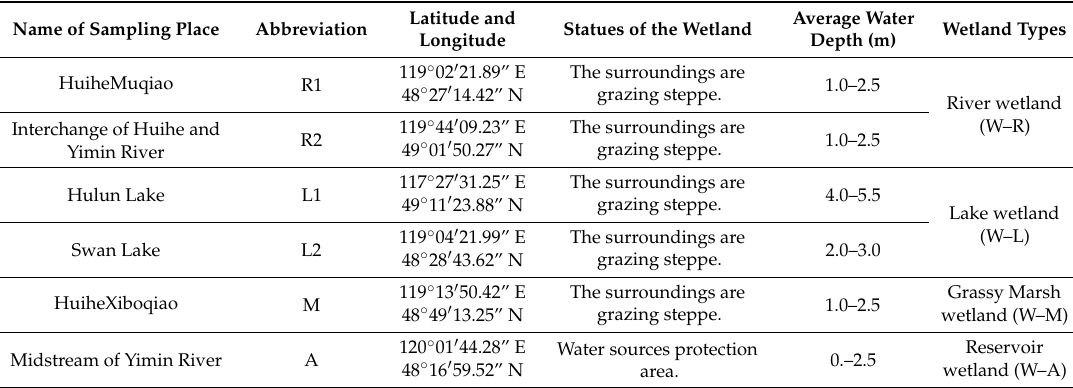
Table 1. Site details of the six wetlands selected in the